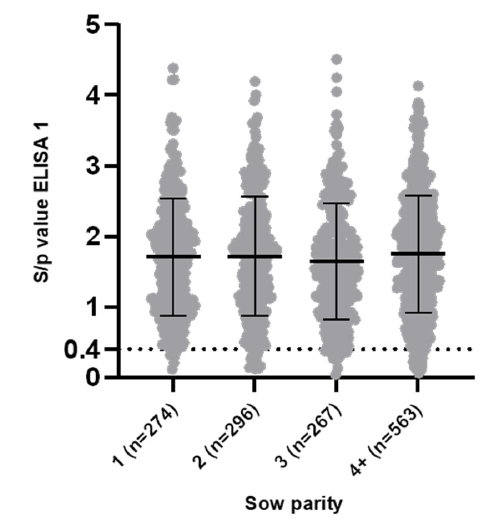
Figure 1. ELISA 1 (IDEXX PRRS X3) sample-to-positive (S/p) values in 1400 sow samples (parity 1 = 274, parity 2 = 296, parity 3 = 267 and parity 4+ = 563) originating from 70 Belgian sow herds that practice routine vaccination against Porcine Reproductive and Respiratory Syndrome virus (PRRSv). Data are shown as individual S/p values, with error bars indicating the mean S/p value and standard deviation for each parity. Cut-off value for seropositivity (S/p ≥ 0.4) is shown as a dotted line. No significant differences in mean S/p values between different parities were found ( p = 0.46). Despite routine PRRSv vaccination, 6/274 (parity 1), 12/296 (parity 2), 9/267 (parity 3) and 22/563 (parity 4+) sows were seronegative in ELISA 1. The proportion of seronegative sows was not significantly different between parities ( p =0.58).